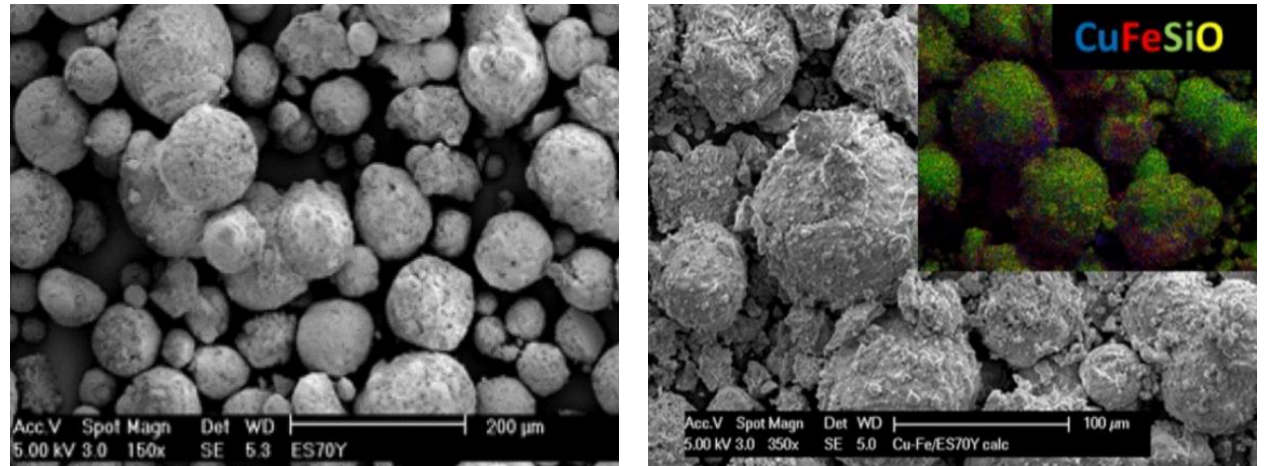
Figure 1. SEM micro-graphs of the “bare” ES70Y micro-spherical silica ( left ) and a representative Cu(x)Fe(y)-Si catalyst sample ( right ). In the inset the elemental mapping of the bimetallic catalyst is represented.